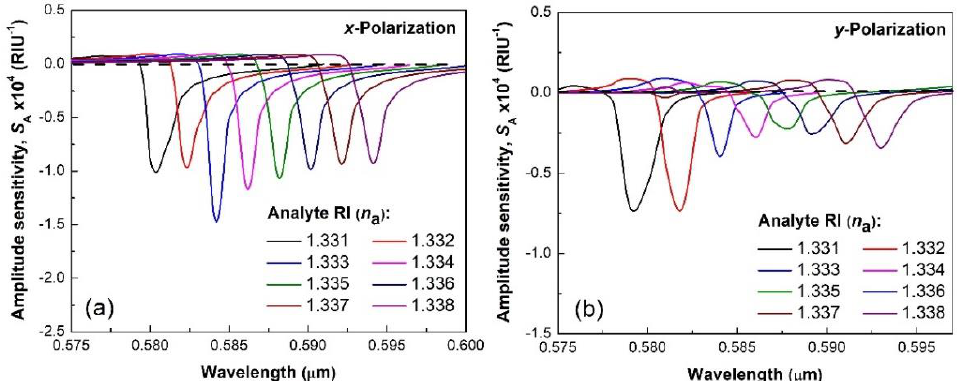
Figure 5. The wavelength-dependent amplitude sensitivity for different analyte RI: ( a ) x and ( b ) y polarized modes for the graphene layer thickness of 36.72 nm.